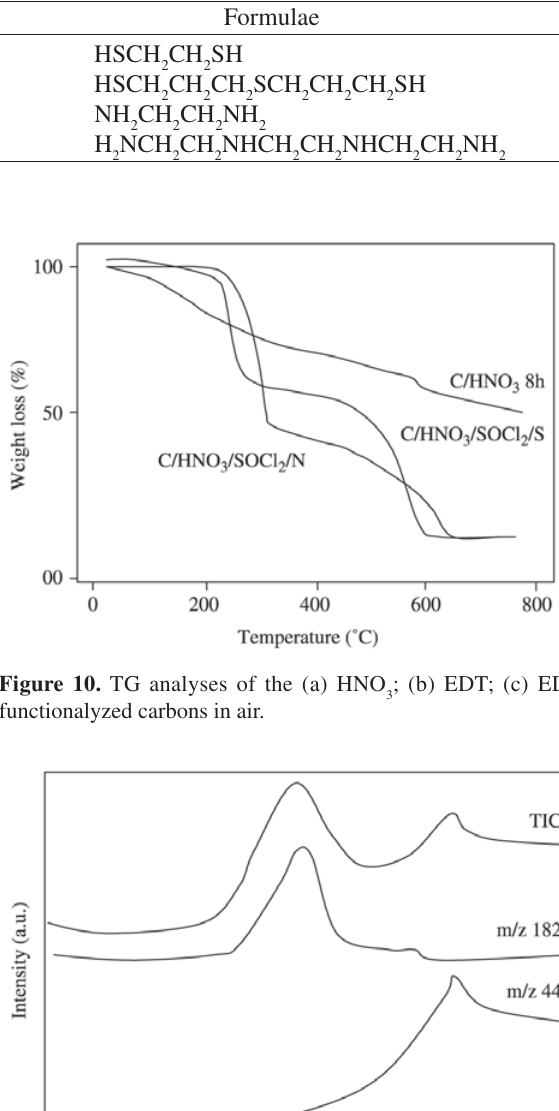
Figure 11. TPDMS experiment with the DMTH functionalised carbon.